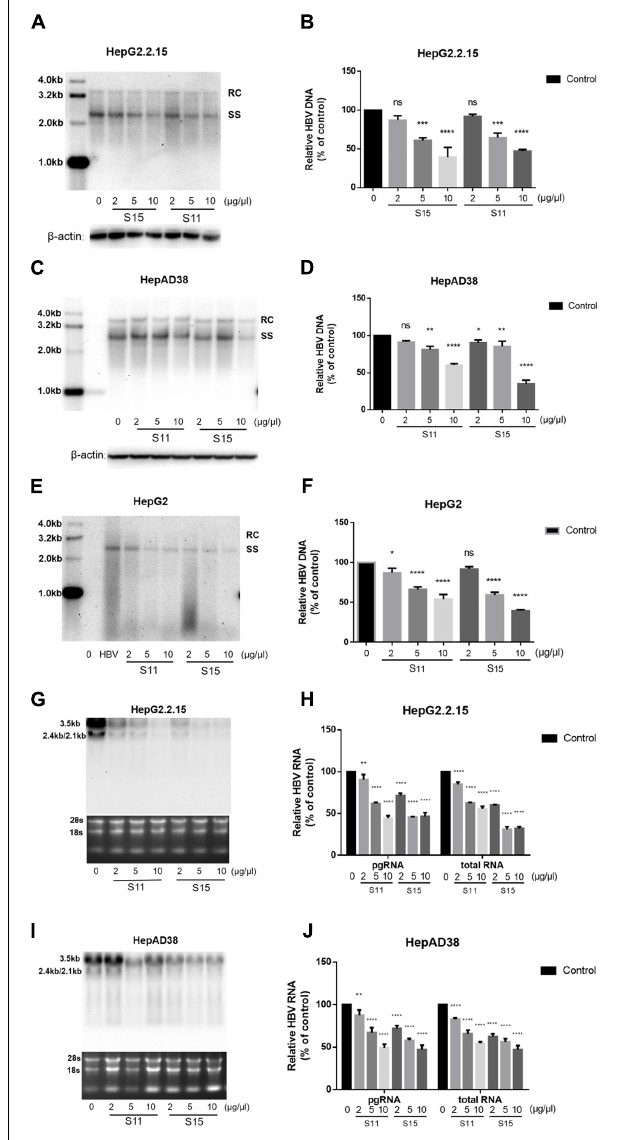
FIGURE 2 | Lettuce extracts S11, S15 suppresses HBV replication in a dose-dependent manner in HepG2.2.15 cells, HpeAD38 cells and HepG2 cells transiently transfected with HBV. HBV replication intermediates were extracted and detected by southern blot hybridization (A,C,E) and quantified using fluorescence quantitative PCR (B,D,F) . The positions of relaxed circular (RC) and single-stranded (SS) DNA forms are indicated. Viral RNAs were examined by Northern blot (G,I) and quantified using fluorescence quantitative PCR (H,J) . All values are expressed as percentages relative to untreated control. RC, relaxed circular DNA; SS, single-stranded DNA. β -actin served as the DNA loading control and 18S/28S RNAs served as the RNA loading control. Statistical significance was calculated using student’s t -test. Ns, not significant, ∗ P < 0.05, ∗∗ P < 0.005, ∗∗∗ P < 0.0005, ∗∗∗∗ P < 0.0001.